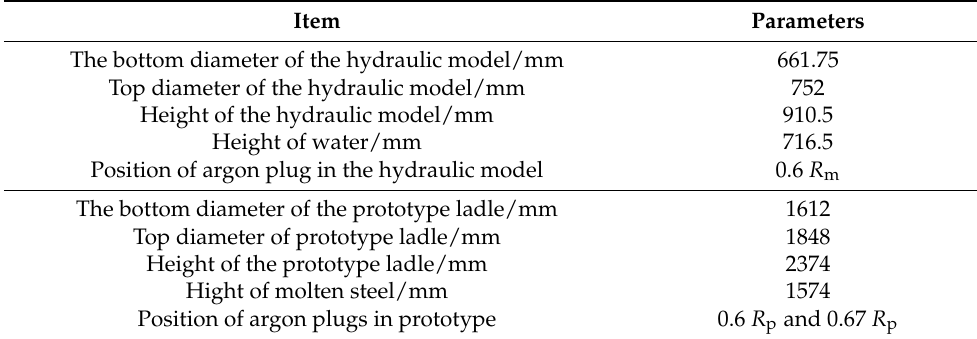
Table 1. The dimensions of argon-stirred ladle in prototype and water model. Item Parameters The bottom diameter of the hydraulic model/mm 661.75 Top diameter of the hydraulic model/mm 752 Height of the hydraulic model/mm 910.5 Position of argon plug in the hydraulic model The bottom diameter of the prototype ladle/mm Top diameter of prototype